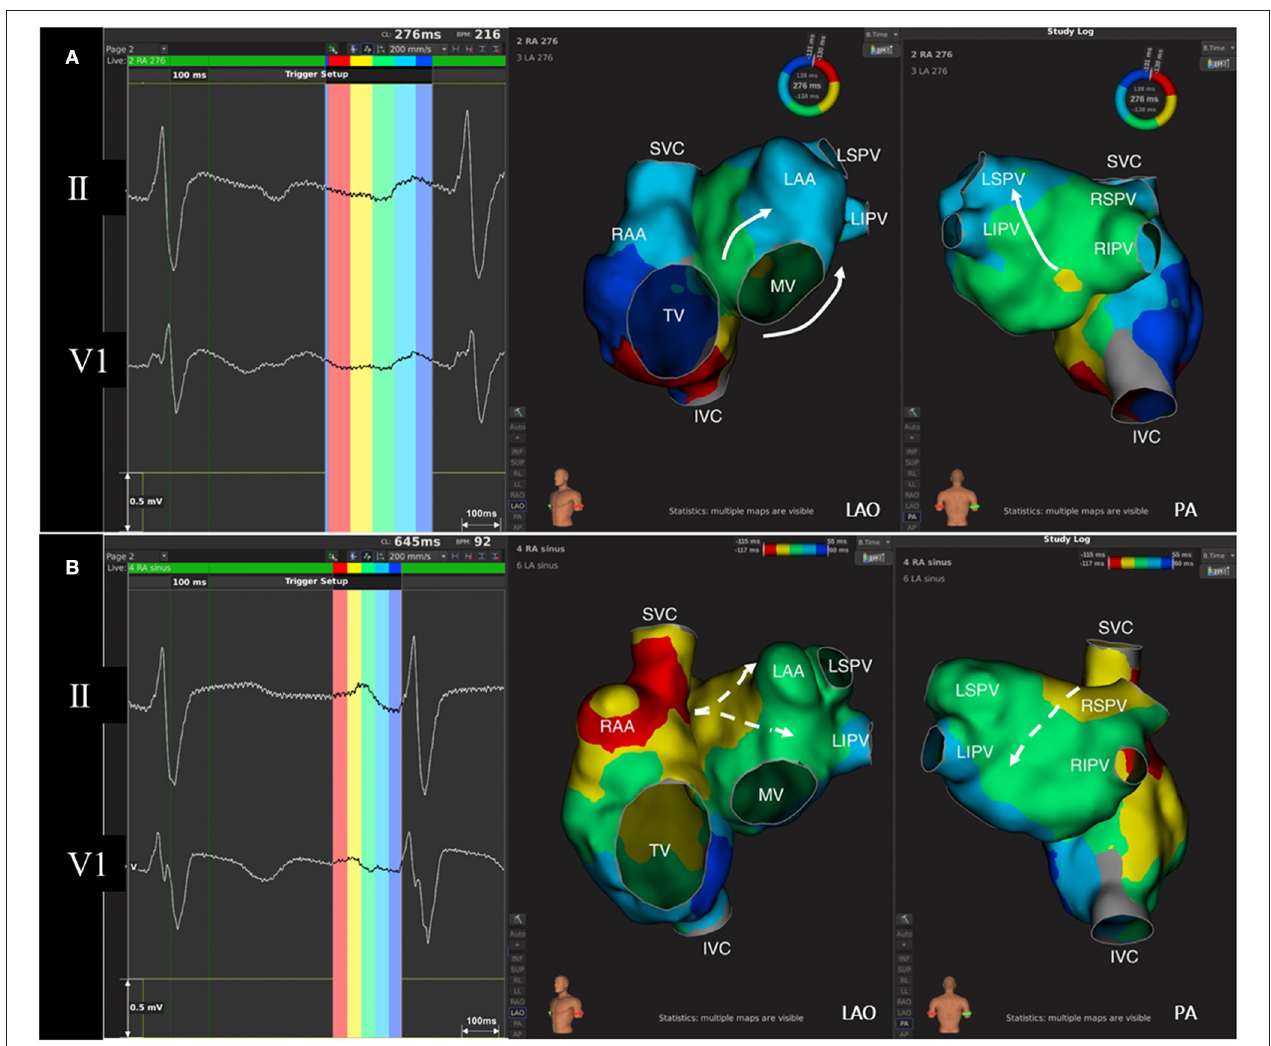
FIGURE 3 | The correlation between regional atrial activation and the components of flutter wave and P wave. (A) Flutter wave and isochronal activation mapping of both the atria during AFL. Left atrium activation during typical counterclockwise AFL goes from inferior-septal wall to superior-lateral wall (white arrow). The negative component of flutter wave in lead II corresponds to the activation of right atrial septum and left atrium, while the positive component of flutter wave indicates right atrial free-wall activation. (B) P wave and isochronal activation mapping of both the atria during sinus rhythm. P wave in lead V1 is normally biphasic. The initial positive force indicates right atrial activation, while left atrial activation from septum to free wall (white dashed arrow) contributes to the terminal negative force in lead V1. AFL, atrial flutter; IVC, inferior vena cava; LAA, left atrial appendage; LAO, left anterior oblique; LIPV, left inferior pulmonary vein; LSPV, left superior pulmonary vein; MV, mitral valve; PA, posterior-anterior; RAA, right atrial appendage; RIPV, right inferior pulmonary vein; RSPV, right superior pulmonary vein; SVC, superior vena cava; TV, tricuspid